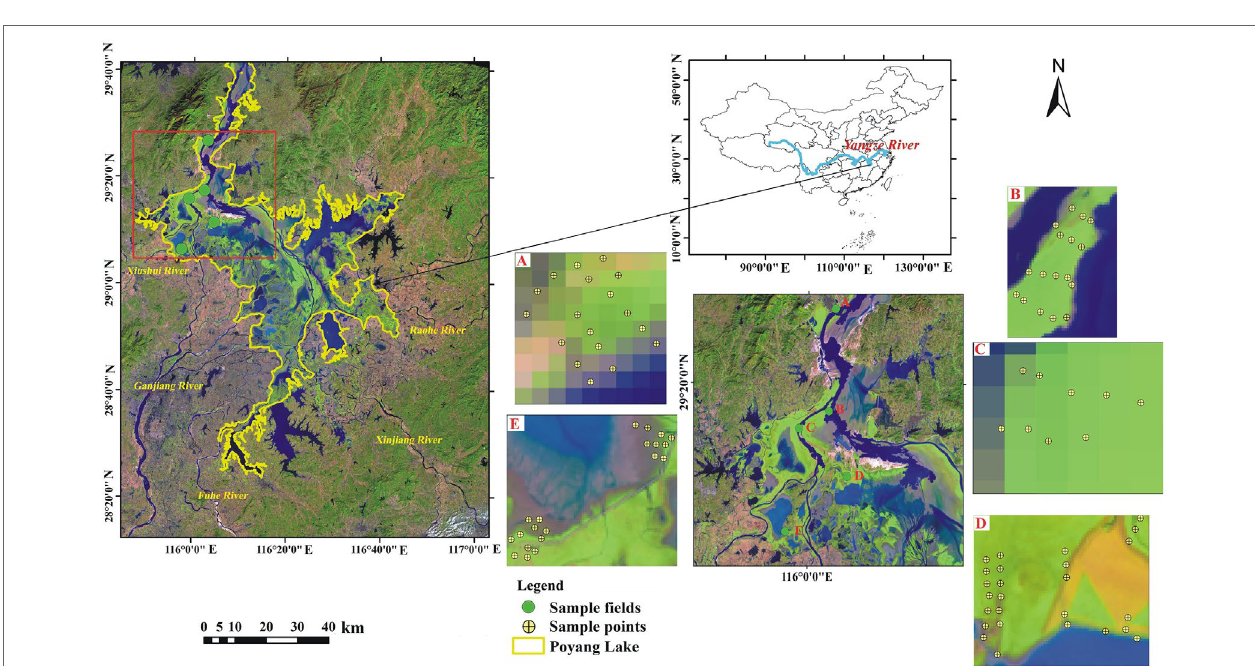
FIGURE 1 | Location of Poyang Lake and the distribution of field sampling sits in 2016. (A) Xingzi littoral land; (B) Ganjang river delta; (C) Sidu Island; (D) Dachahu sub-lake; (E) Dahuchi sub-lake.